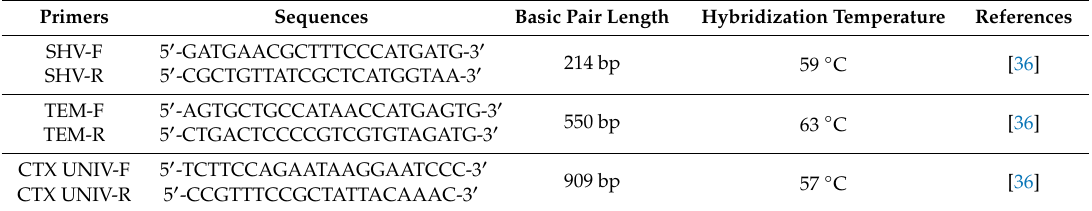
Table 1. The di ff erent primers used for polymerase chain reaction (PCR) and bacterial identification. Primers Sequences Basic Pair Length Hybridization